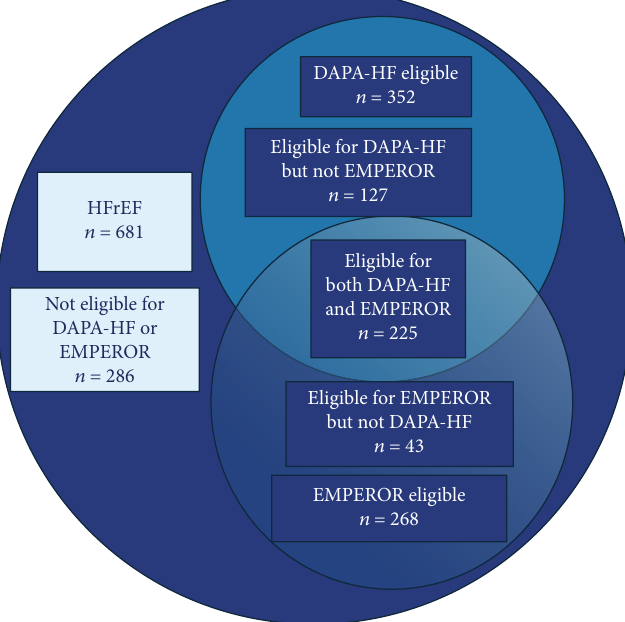
Figure 2: Distribution of patients according to eligibility status for DAPA-HF and